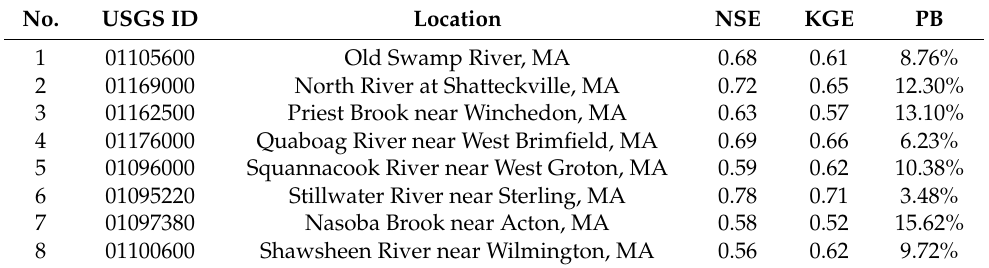
Table 3. List of model calibration sites and validation statistics for annual mean